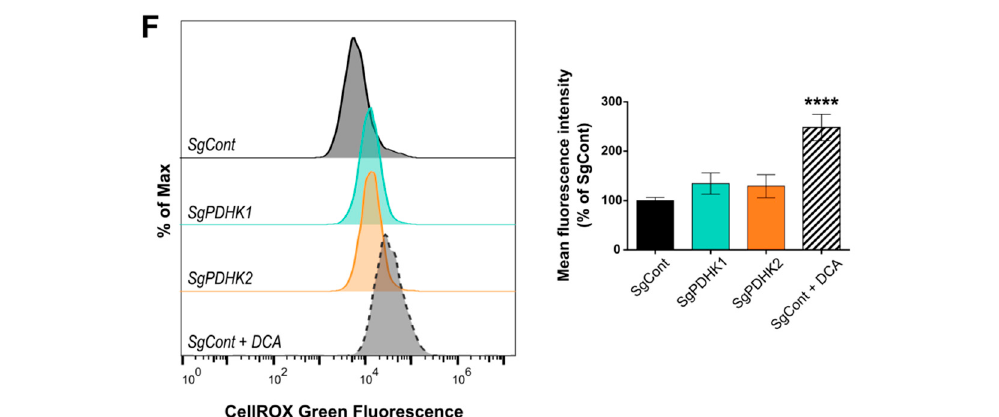
Figure 3. DCA disturbs GB cell metabolism and induces ROS production. ( A ) The extracellular acidification rate (ECAR) was measured in real time upon the addition of 20 mM DCA/vehicle to P3 wt cells. Values are presented as the percentage change compared with basal ECAR prior to DCA addition. ( B ) Intra- ( left ) and extracellular ( right ) lactate measurement in P3 SgCont, SgPDHK1, SgPDHK2 or with DCA treatment (25 mM for 3 days), upon 21% or 0.1% O 2 exposure; n = 7 to 8 for each condition; when not noticed, significance was assessed by comparing with control cells 21% O 2 . ( C ) The oxygen consumption rate (OCR) was measured in real time upon the addition of 20 mM DCA/vehicle to P3 wt cells. Values are presented as the percentage change compared with basal OCR prior to DCA addition. ( D ) Oxygraphy analysis of P3 cells in a phosphorylating state (basal cell respiration), non-phosphorylating state (oligomycin addition) or uncoupled state (CCCP addition); n = 4. ( E ) Sensitivity in P3 cells to specific OxPhos complex inhibitors rotenone (complex I), atpeninA5 (complex II) and antimycin A (complex III); n = 4. The addition of inhibitors was performed upon uncoupled respiration conditions and results are expressed as the percentage of uncoupled respiration prior inhibitor addition (%JO2cccp). ( F ) ROS production assessed in triplicates with CellROX Green probe in PDHK1 or PDHK2 KO cells, or in control cells exposed to 3 days of DCA treatment (25 mM). Left panel : Representative histograms in modal scaling (percentage of Max). Right panel : Quantification of mean fluorescence intensity, expressed as the percentage of control cells. Data are expressed as the mean ± SEM, and p -values were obtained using unpaired t -tests ( A , C ), one-way ANOVA ( F ) or two-way ANOVA ( B , D , E ); * p < 0.05; ** p < 0.01; **** p <